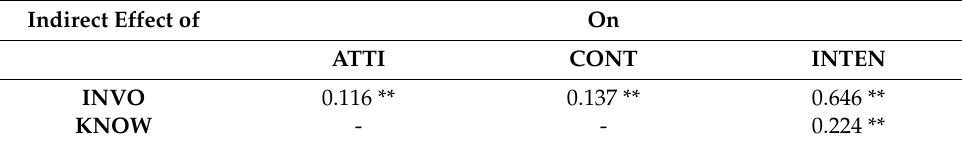
Table 3. Summary of indirect effect assessment results.